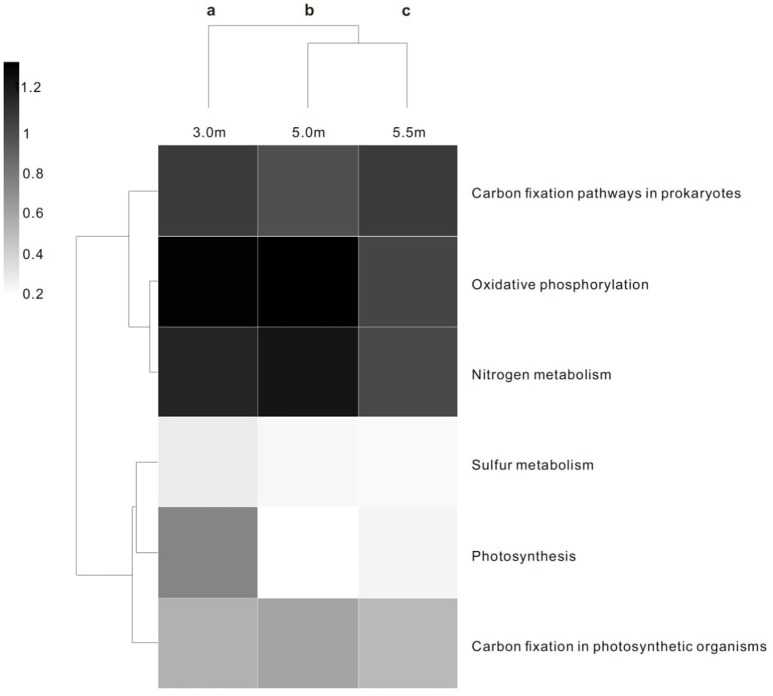
Heat map and functional clustering of predicted ORFs from microbial metagenomic contigs based on KO of energy metabolism at three depths. The heat scale is the relative abundance of ORFs assigned to each individual KO of energy metabolic category. a−cDifferent letters denote a significant difference in the statistical test (P < 0.05).